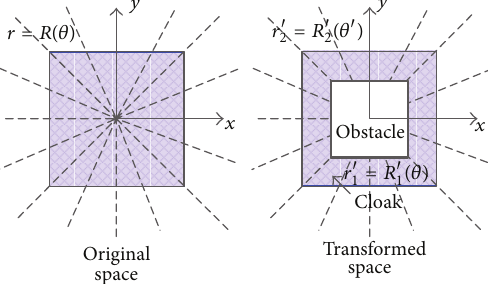
Figure 2: The generalized coordinate